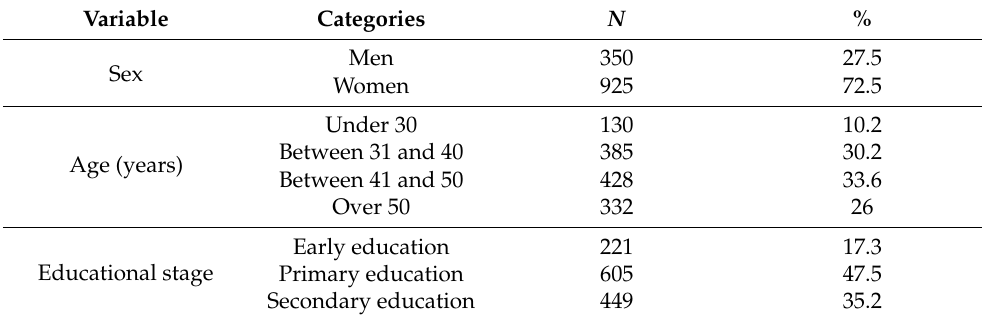
Table 2. Sample characterization for this study ( n =